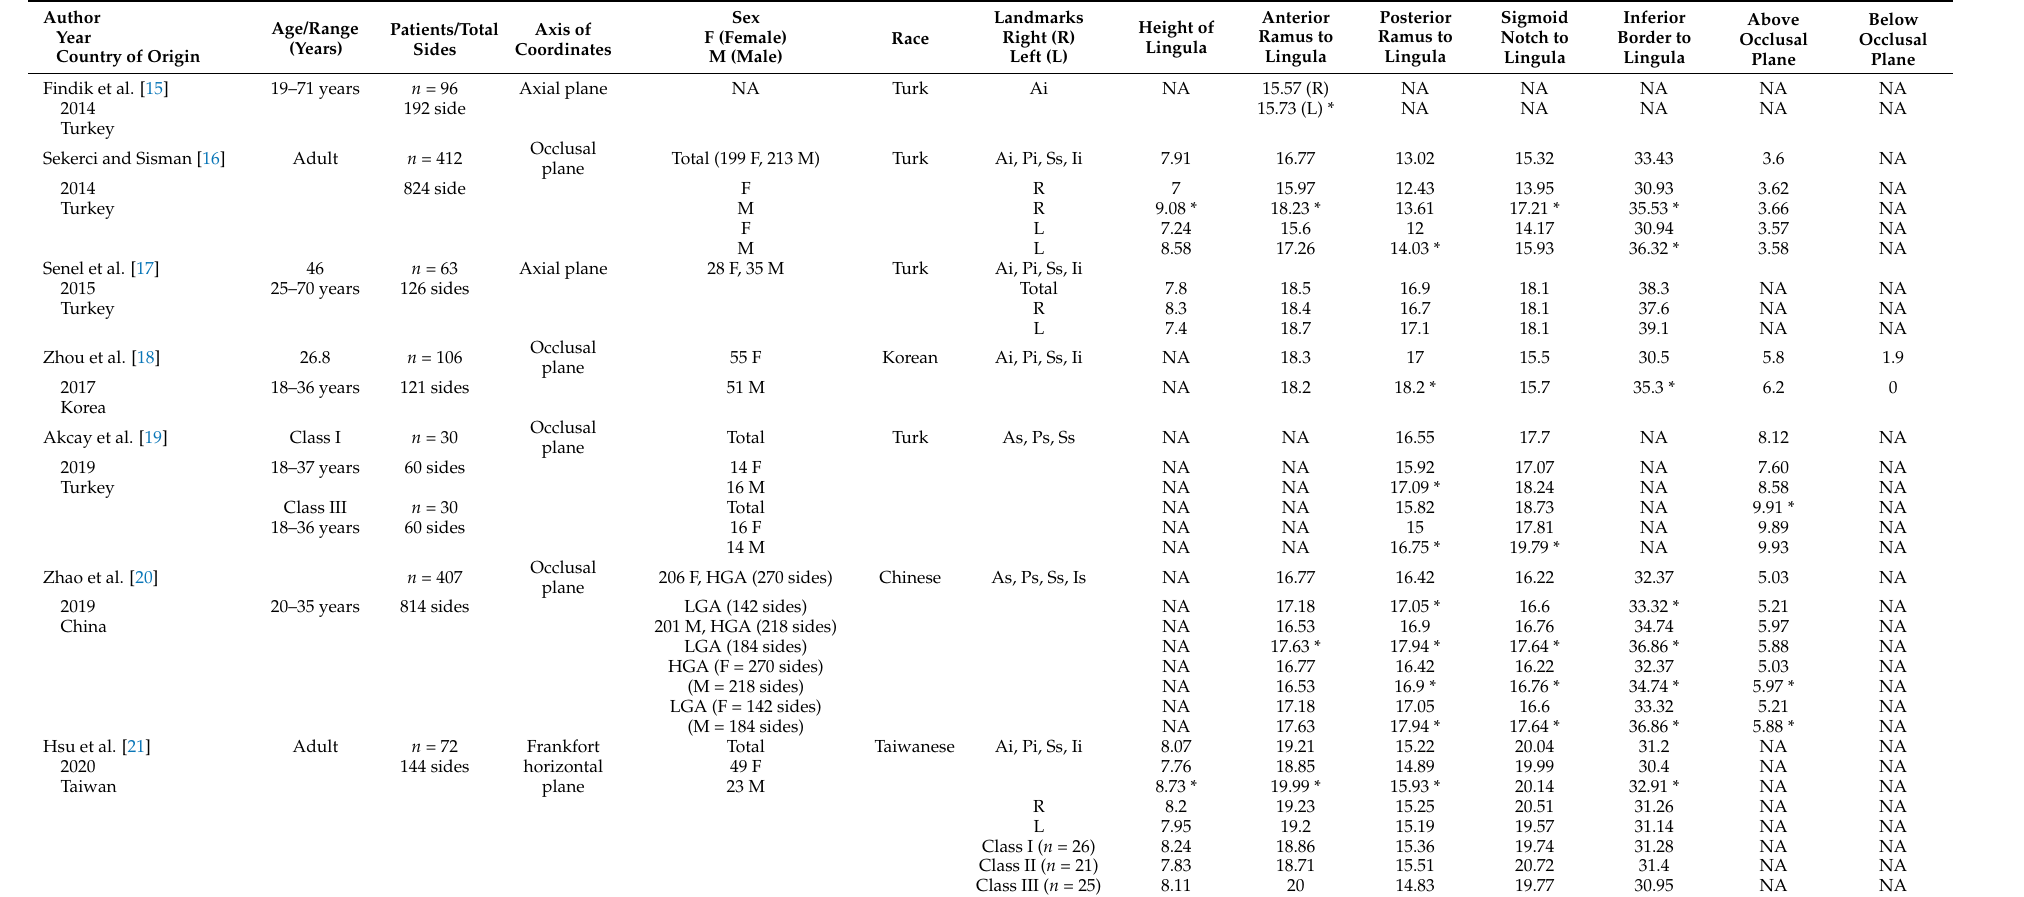
Table 1. Demographic and study characteristics in the included studies (cone-beam computed tomography: